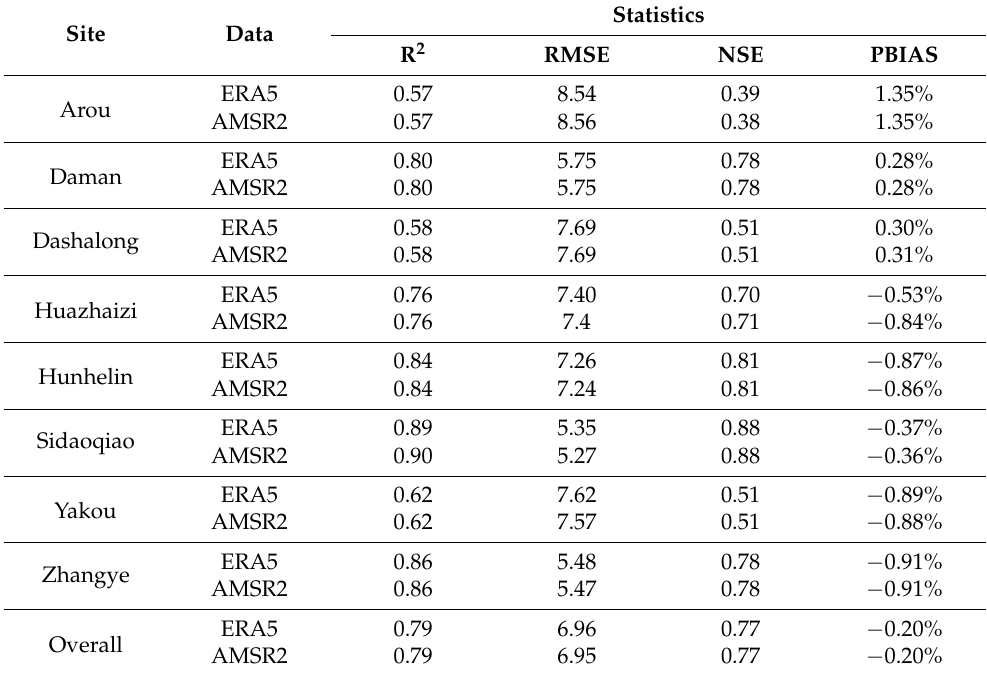
Table 5. Validation of reconstructed LST using classification and adaptive window from 2016 to